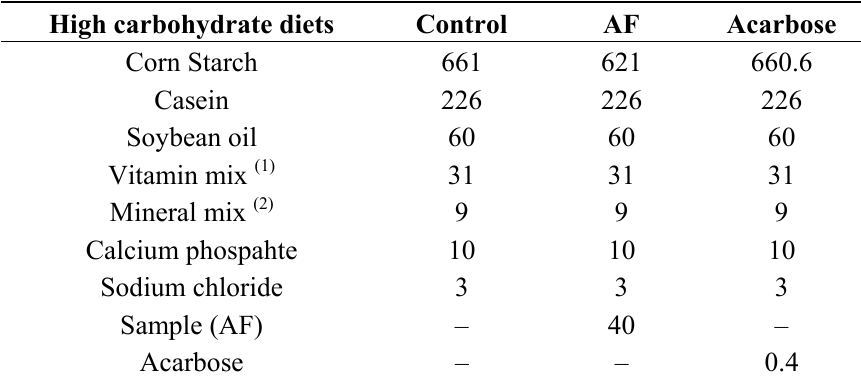
Table 2. Composition of diets